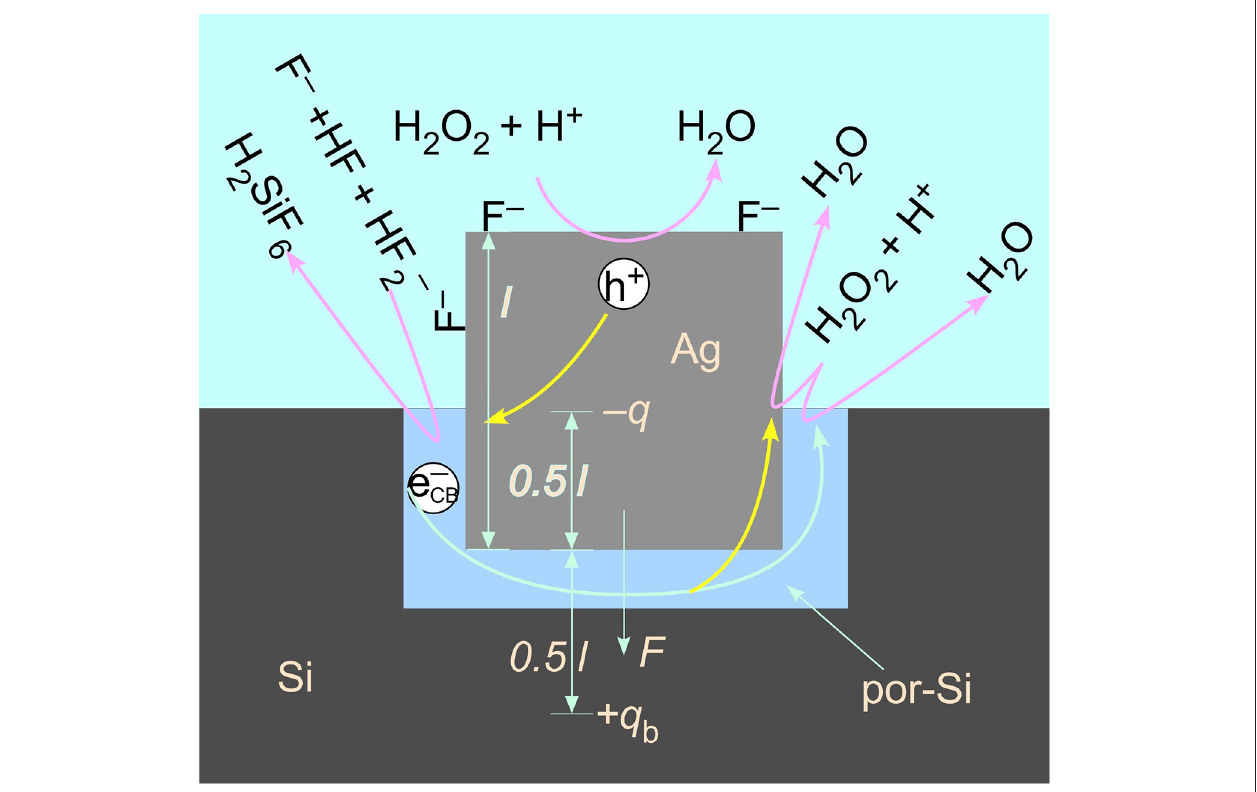
FIGURE 5 | A model of the electrostatic interaction of a charged particle and its image charge located in bulk Si across an intervening porous region. An excess of adsorbed anions, such as F − , leads to a net negative charge on the metal catalyst. Reactions pertinent to valence band hole injection by H 2 O 2 decomposition, Si etching by complexation of Si to H 2 SiF 6 by fluoride species, and capture by H 2 O 2 of the conduction band electron injected by F − (which can occur either on the metal nanoparticle or on the Si) are also represented. The formation of a porous region in the immediate proximity of the metal/Si interface facilitates the transport of reactants into and products out of the reaction